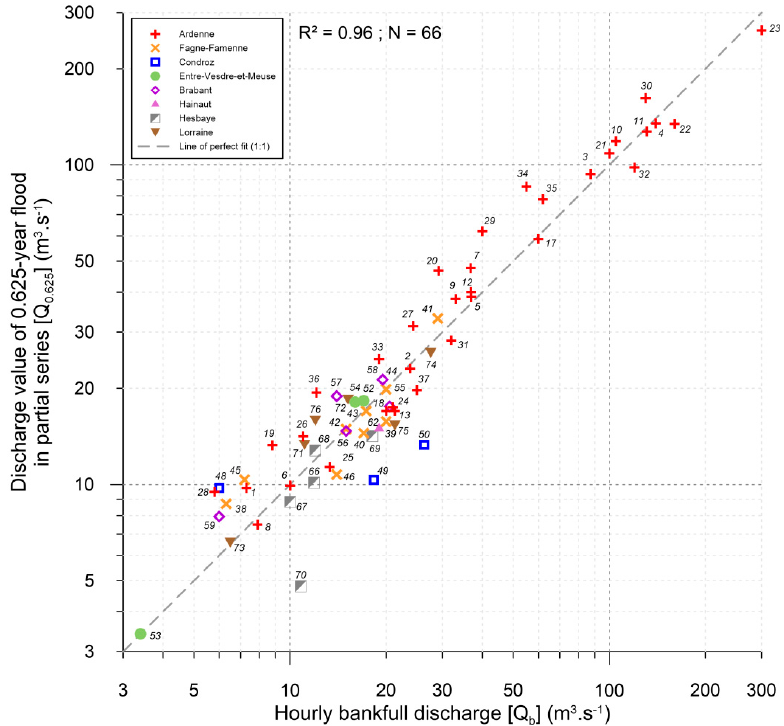
Figure 4. Fit between the discharge value of Q 0.625 in partial series and the field-observed Q b .